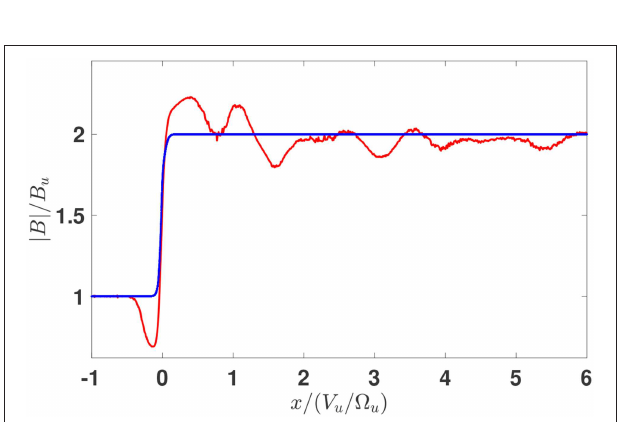
FIGURE 2 | The model magnetic field (blue) and the predicted magnetic field (red). The adjusted parameters are: M